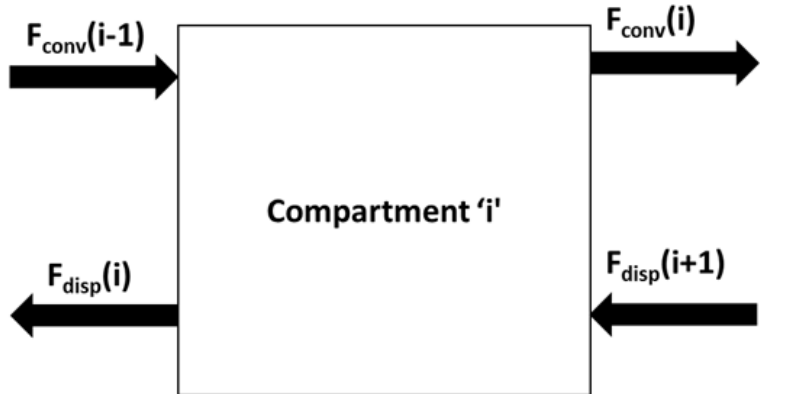
Figure 2. Schematic showing the convective and dispersive fluxes entering and leaving a compart- ment with index